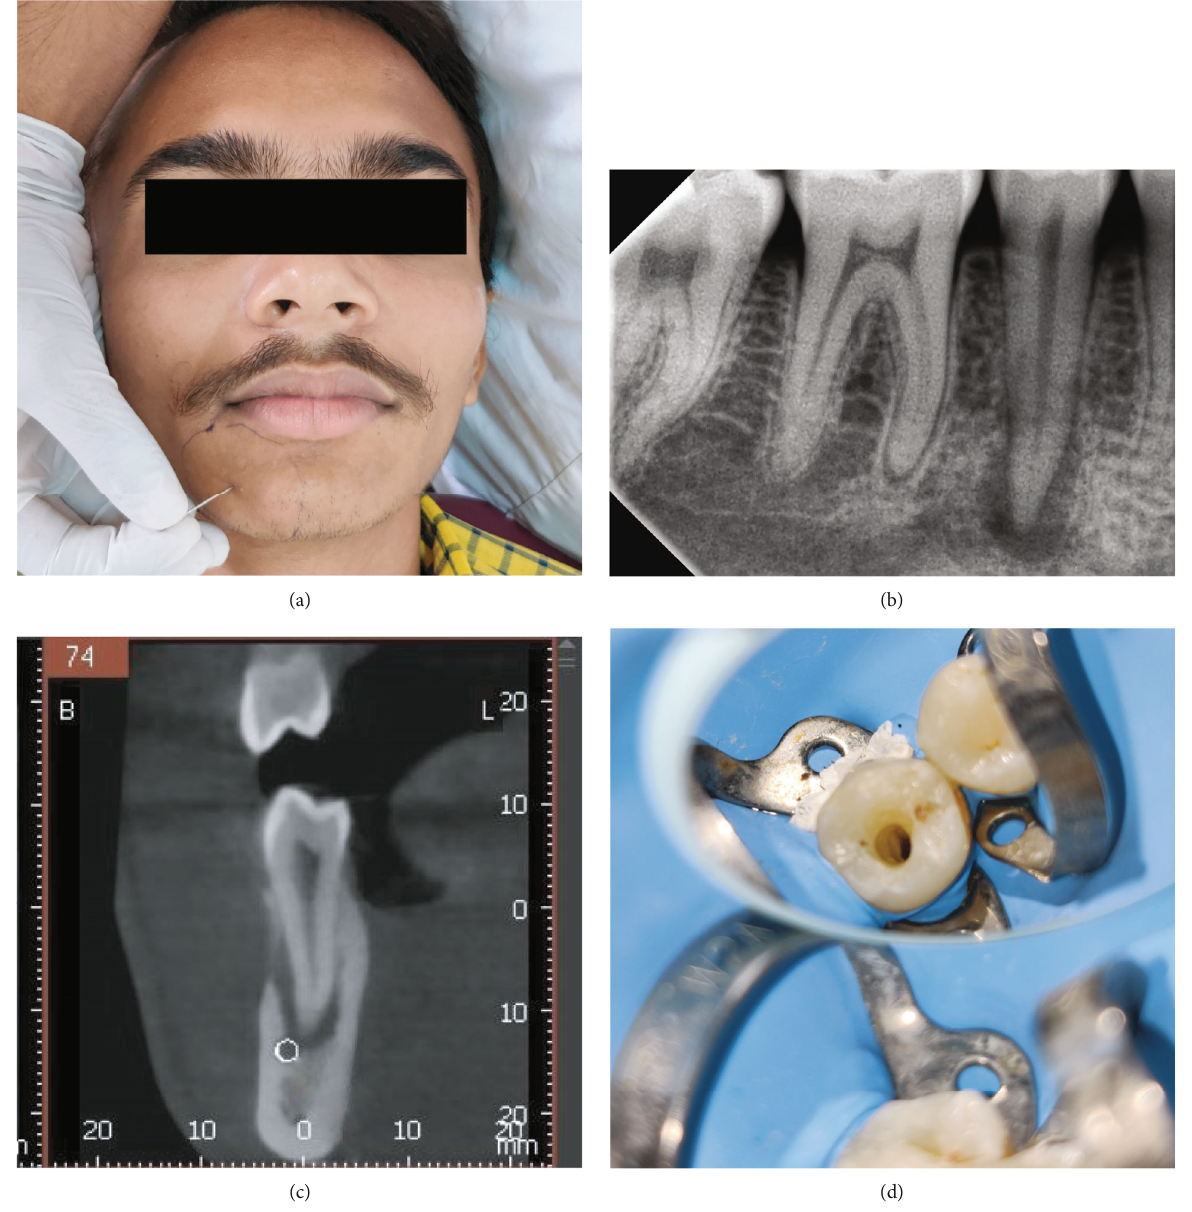
Figure 1: (a) Paraesthesia testing, (b) preoperative RVG, (c) preoperative CBCT, and (d) access cavity under dental